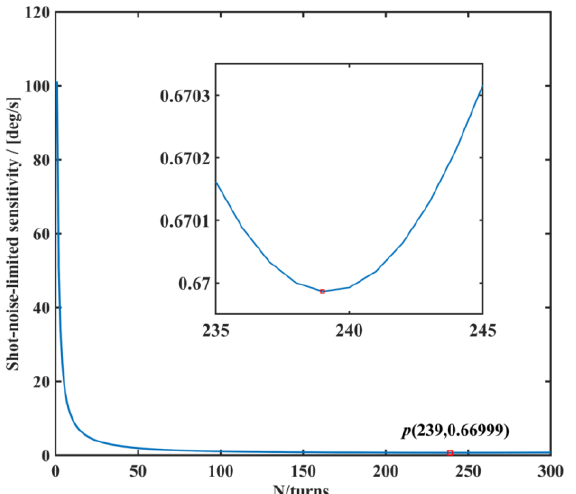
Figure 12. Variation of gyroscope sensitivity with the number of turns of the waveguide